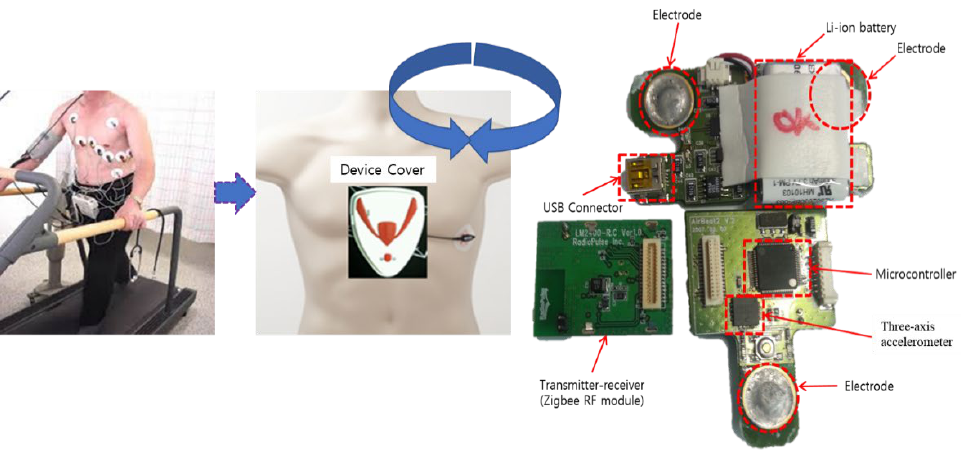
Figure 1. Proposed design for energy expenditure (EE) measurement.